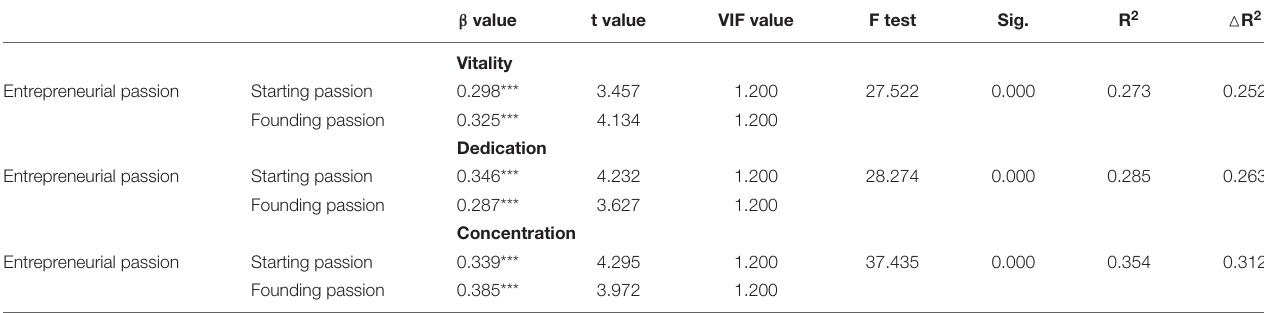
FIGURE 8 | Multiple regression analysis of entrepreneurial passion and work engagement risk taking [ (A) data analysis data; (B) calculation and statistics; A, β value; B, t value; C, VIF value]. TABLE 5 | Multiple regression analysis of entrepreneurial passion and work engagement at all levels. β value t value VIF value F test Sig. R 2